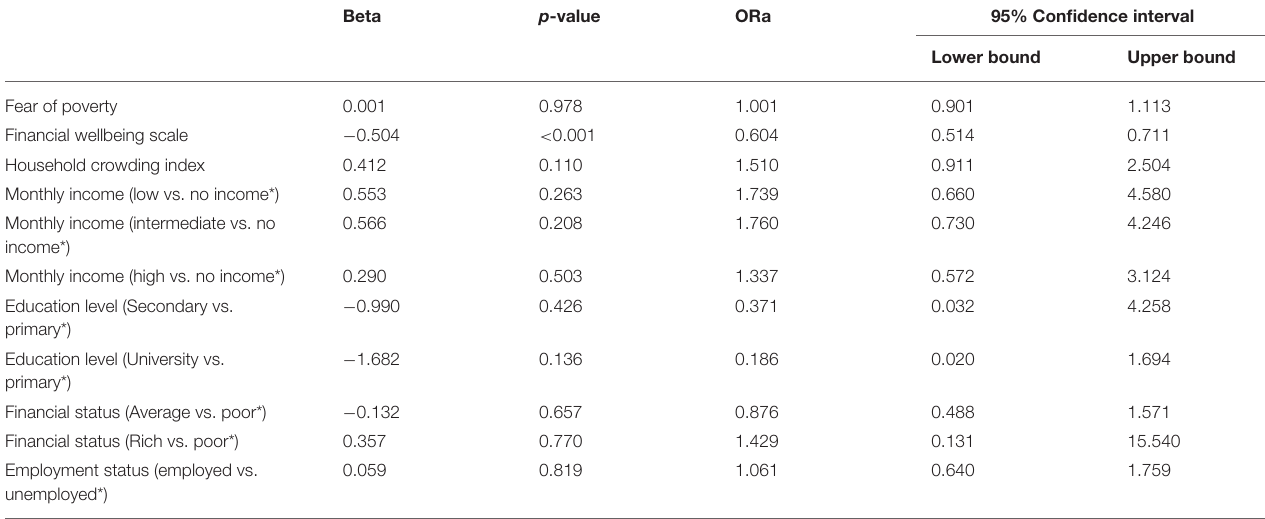
TABLE 3 | Logistic regression analysis taking the food security/food insecurity as the dependent